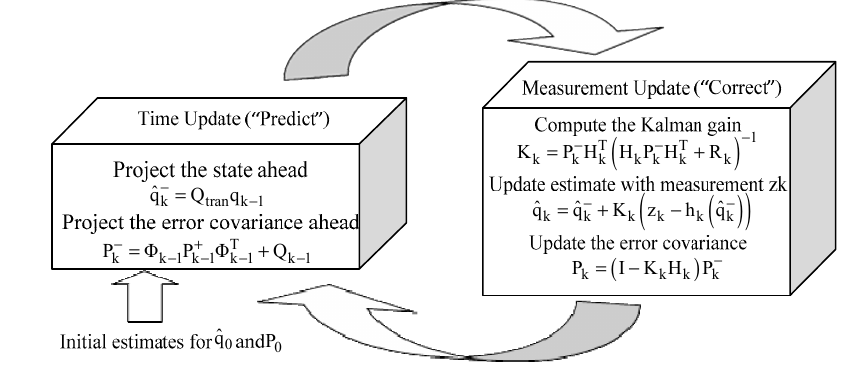
Figure 3. Operation of the EKF. Table 1. EKF elements and